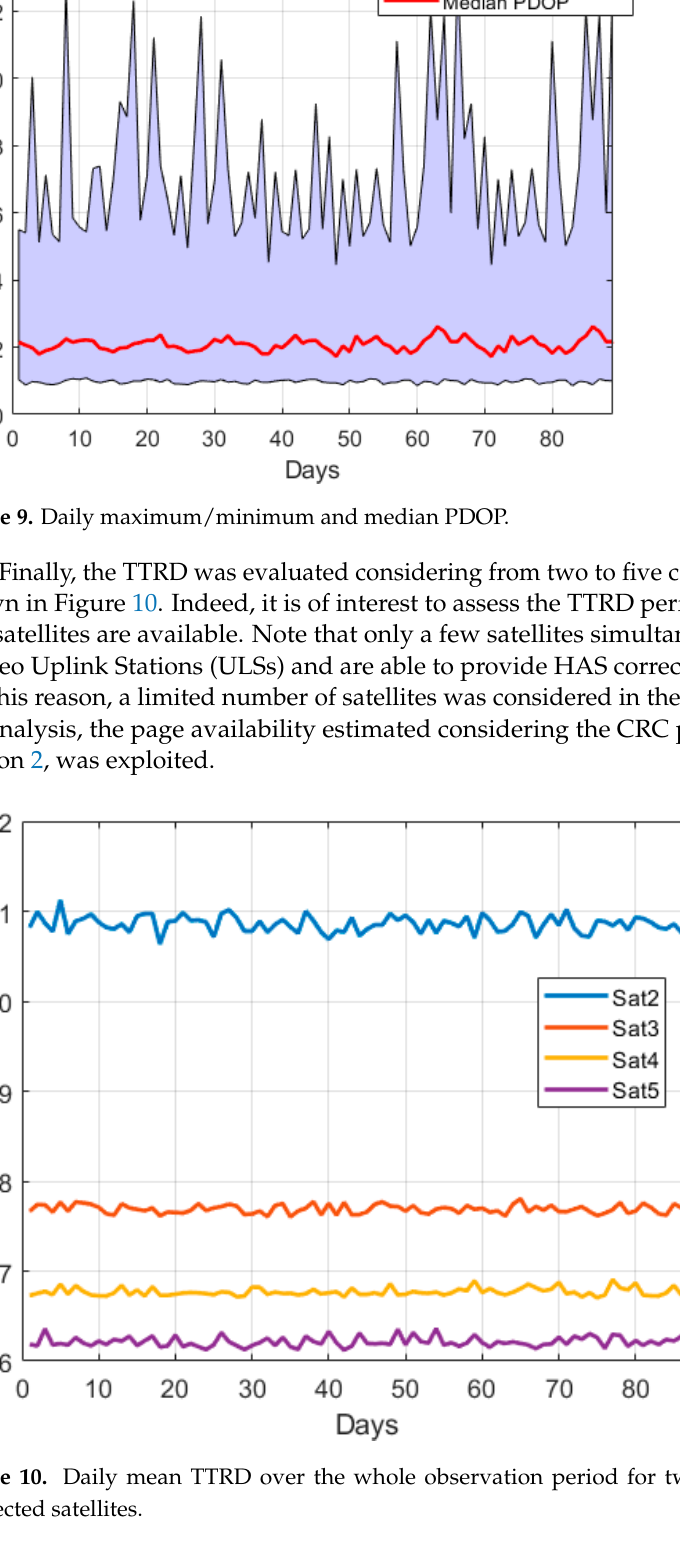
Figure 8. Daily PER for the period under analysis.